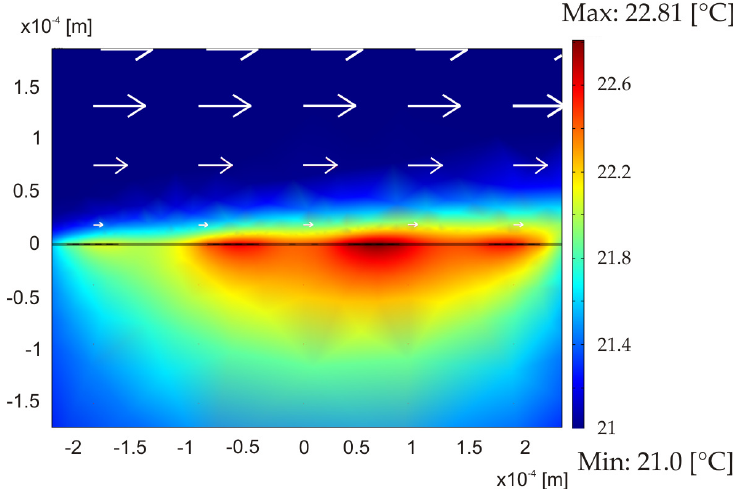
Figure 5. Simulated temperature distribution at the symmetry plane of the sensor for an average flow velocity of v = 20 m/s and a supply current of I = 70 µA (design 1). mean SUP Boundary temperatures were set at ambient temperature T = 21 °C. amb